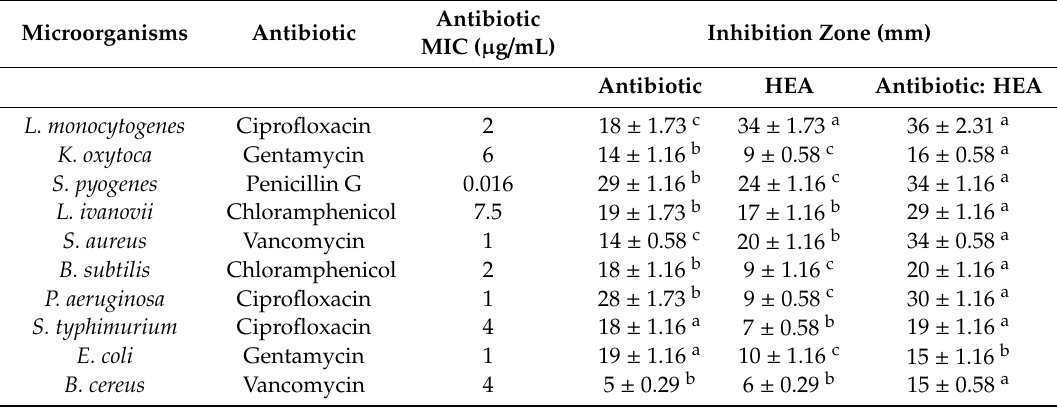
Table 3. Antibacterial activity of mixed combinations of hydrolyzed egg albumin (HEA) and antibiotic. Microorganisms